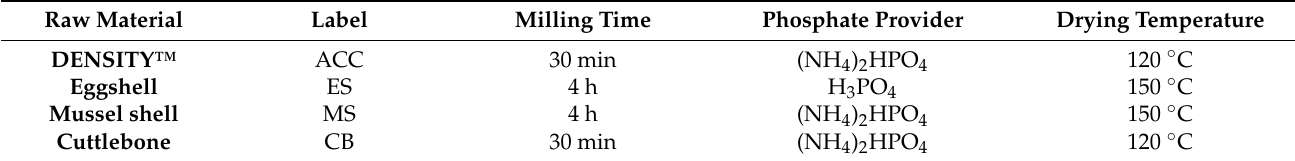
Table 1. The parameters used during the mechanosynthesis